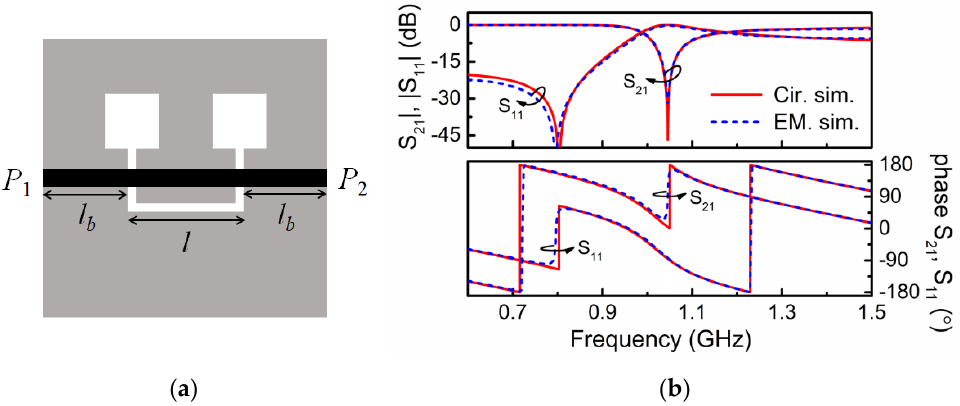
Figure 4. Layout ( a ) and lossless frequency response ( b ) of the folded and 90° rotated DB-DGS. Dimensions are identical to those of Figure 3.